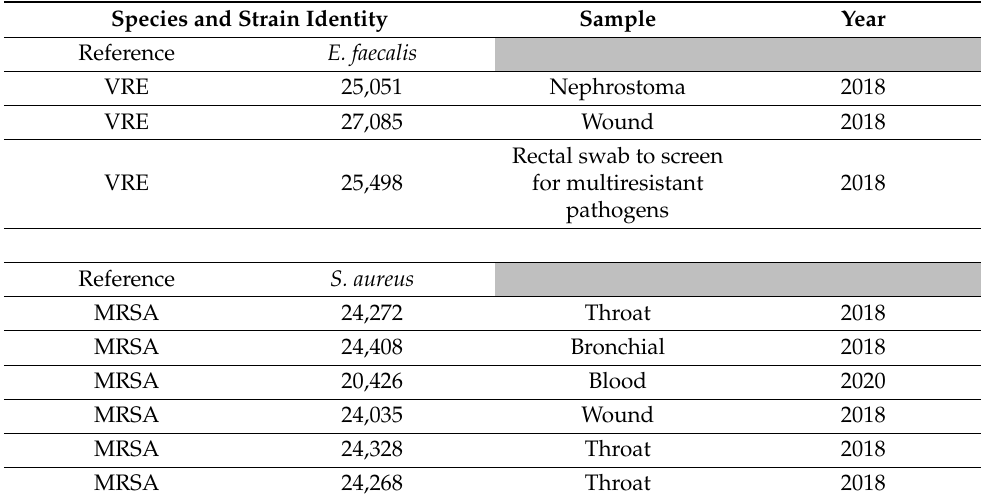
Table 9. The clinical isolates used in the study. VRE—vancomycin-resistant Enterococcus , MRSA— methicillin-resistant Staphylococcus aureus